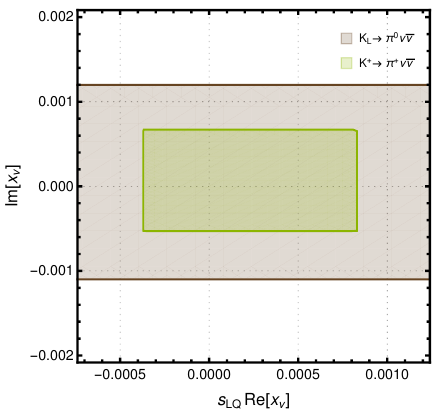
Table 10 . 90% C.L. bounds on leptoquark couplings from K ! (cid:25)(cid:23) (cid:22) (cid:23) decays. The sign factor s LQ = +1 for the leptoquarks S 1 ; 3 , while s LQ = (cid:0) 1 for ~ R 2 .